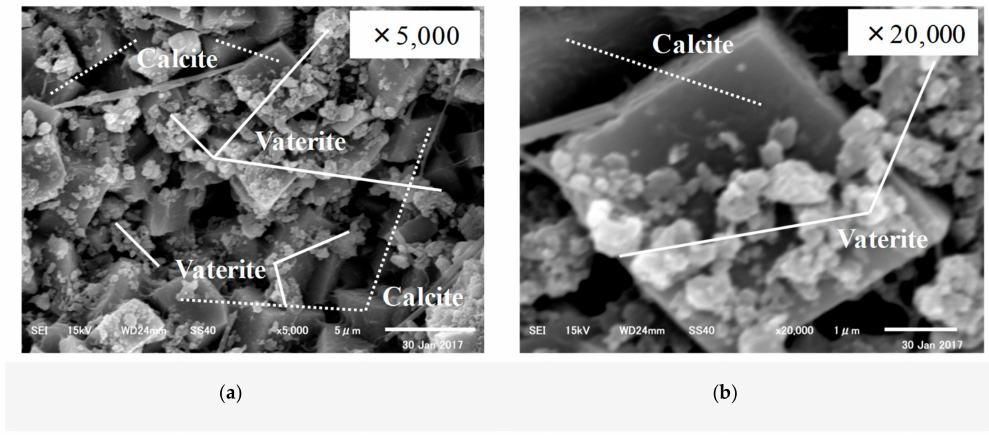
Figure 12. Self-healed substances at 40 ◦ C (CE specimen of IV series) ( a ) 5000x; ( b )